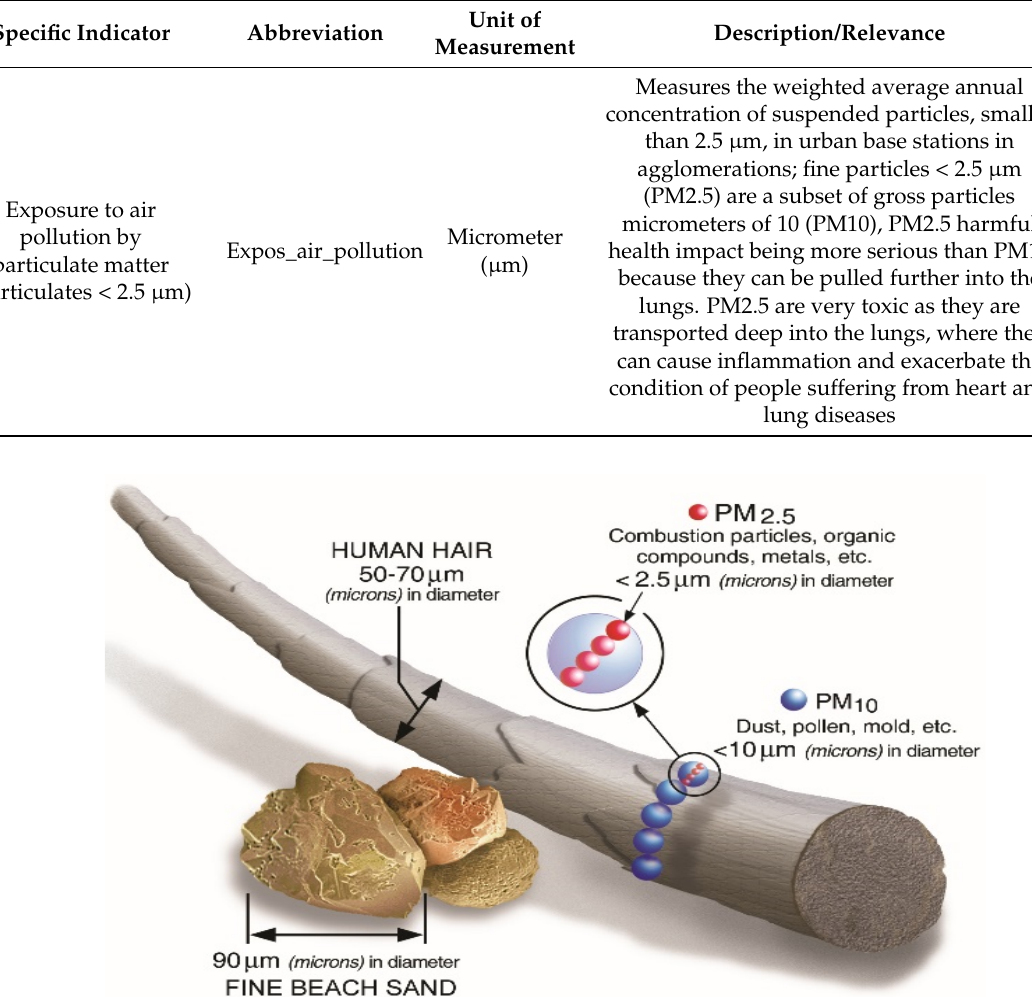
Table 2. The dependent variable used for the panel data regression of the EU-28 Member States.